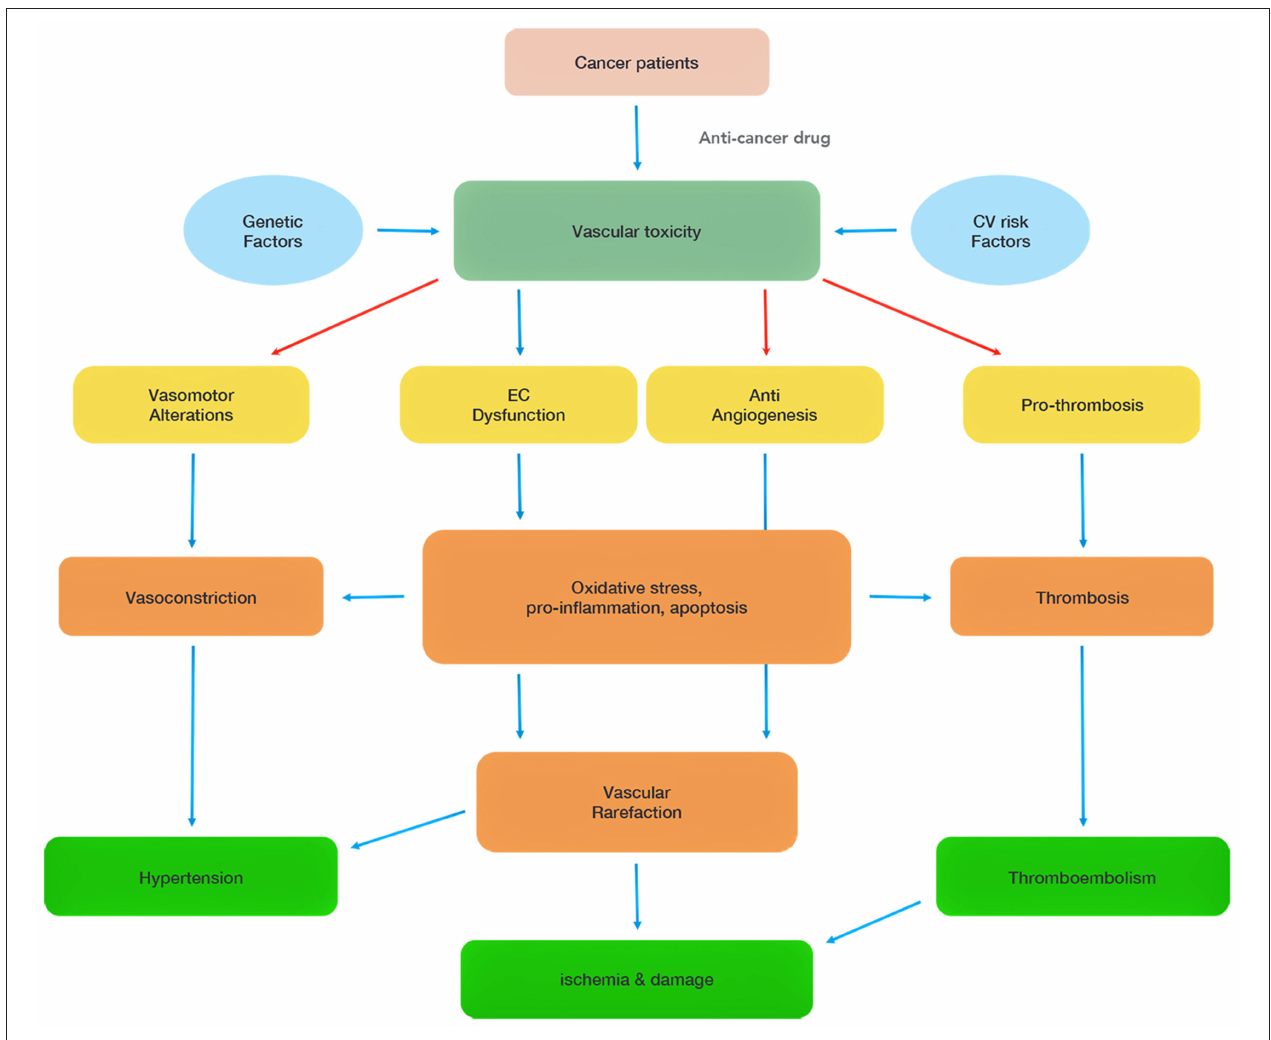
FIGURE 1 | Summary of chemotherapy-associated vascular toxicity. Vascular toxicity can be attributed to four main mechanisms (vasomotor alterations, endothelial cell (EC) dysfunction, anti-angiogenesis, pro-thrombosis), which induce hypertension, ischemia and thromboembolism, and damage heart functions. The red arrows highlight direct effects of some of the